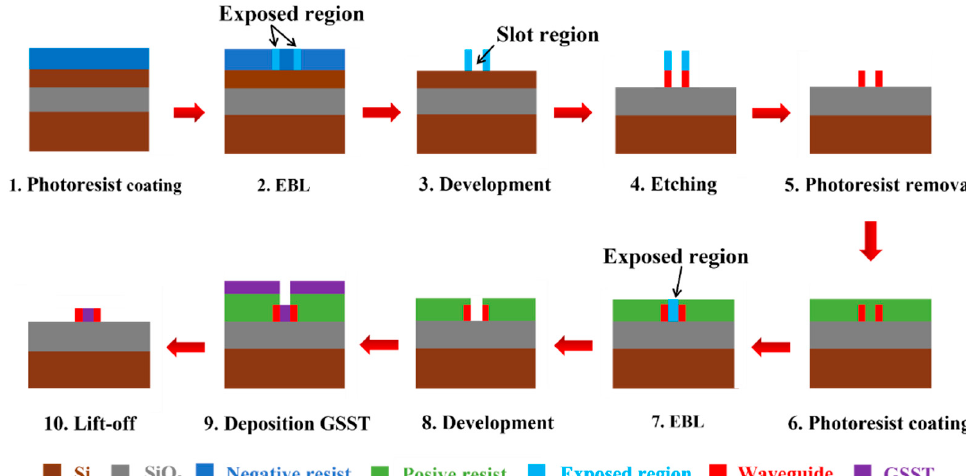
Figure 8. The suggested fabrication process.